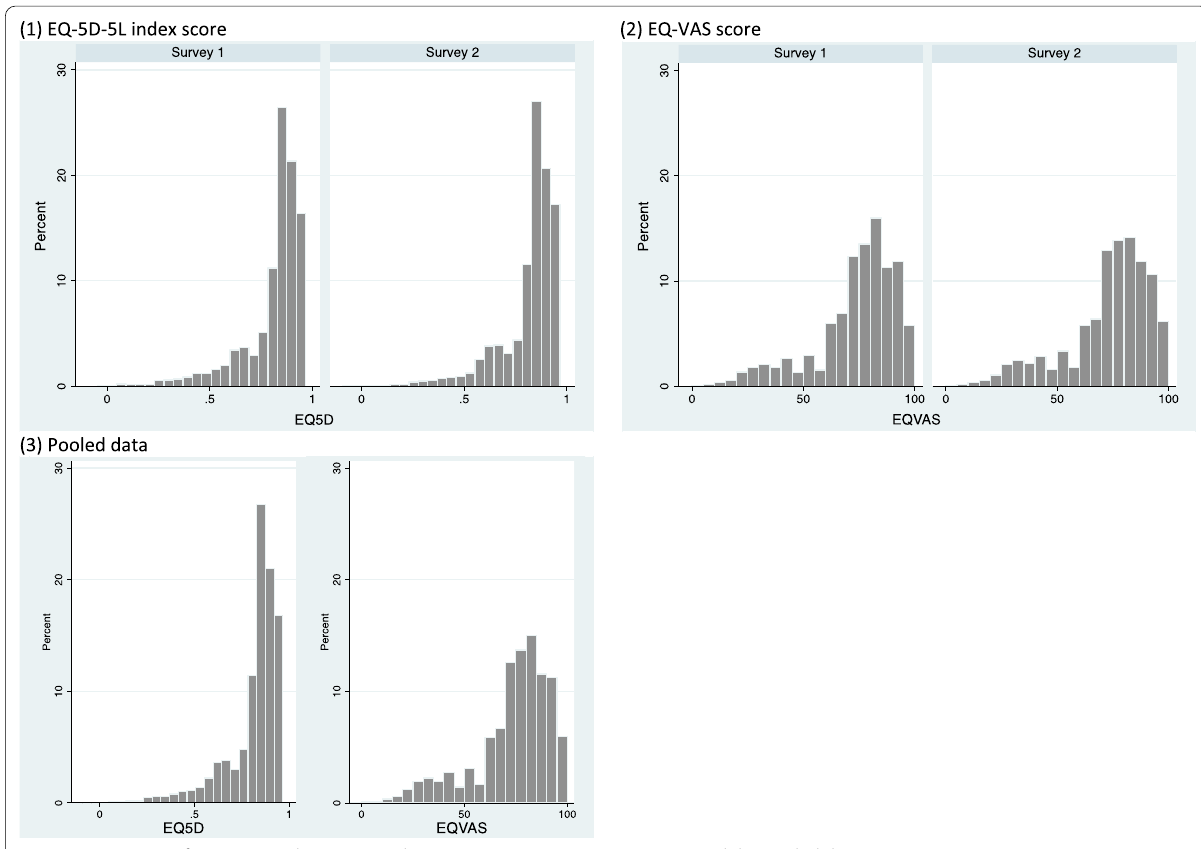
Fig. 1 Histograms of EQ-5D-5L index scores and EQ-VAS scores in survey 1, survey 2, and the pooled